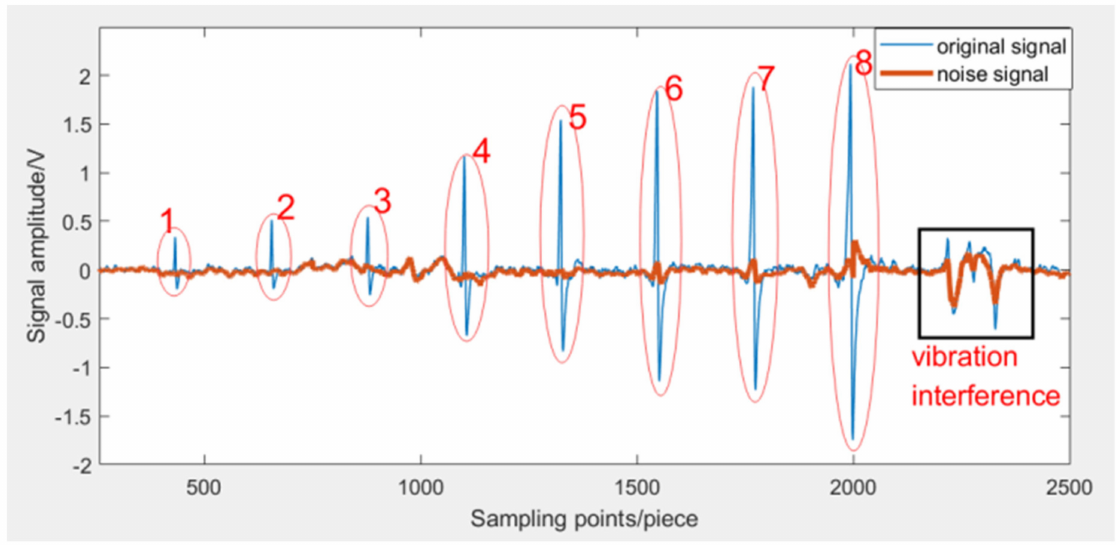
Figure 14. Original signal and vibration signal of the seventh